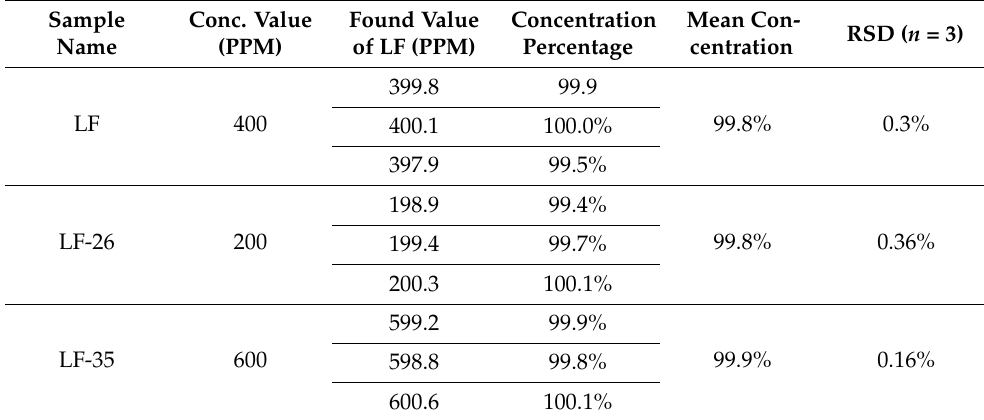
Table 3. Levofloxacin concentration in the original/untreated